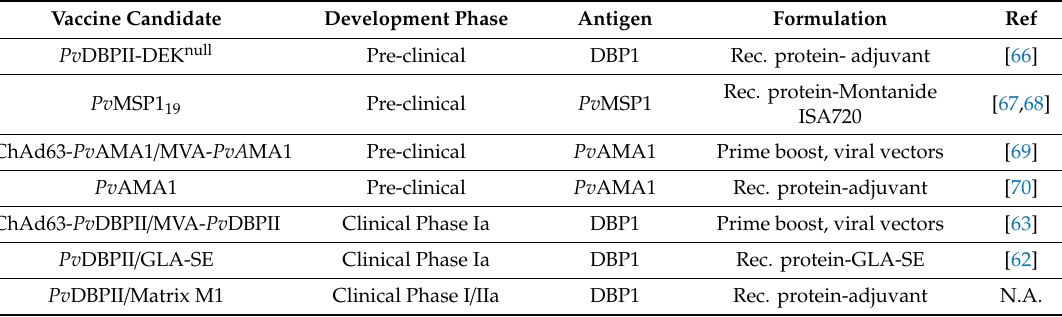
Table 1. Plasmodium vivax blood stage malaria vaccine